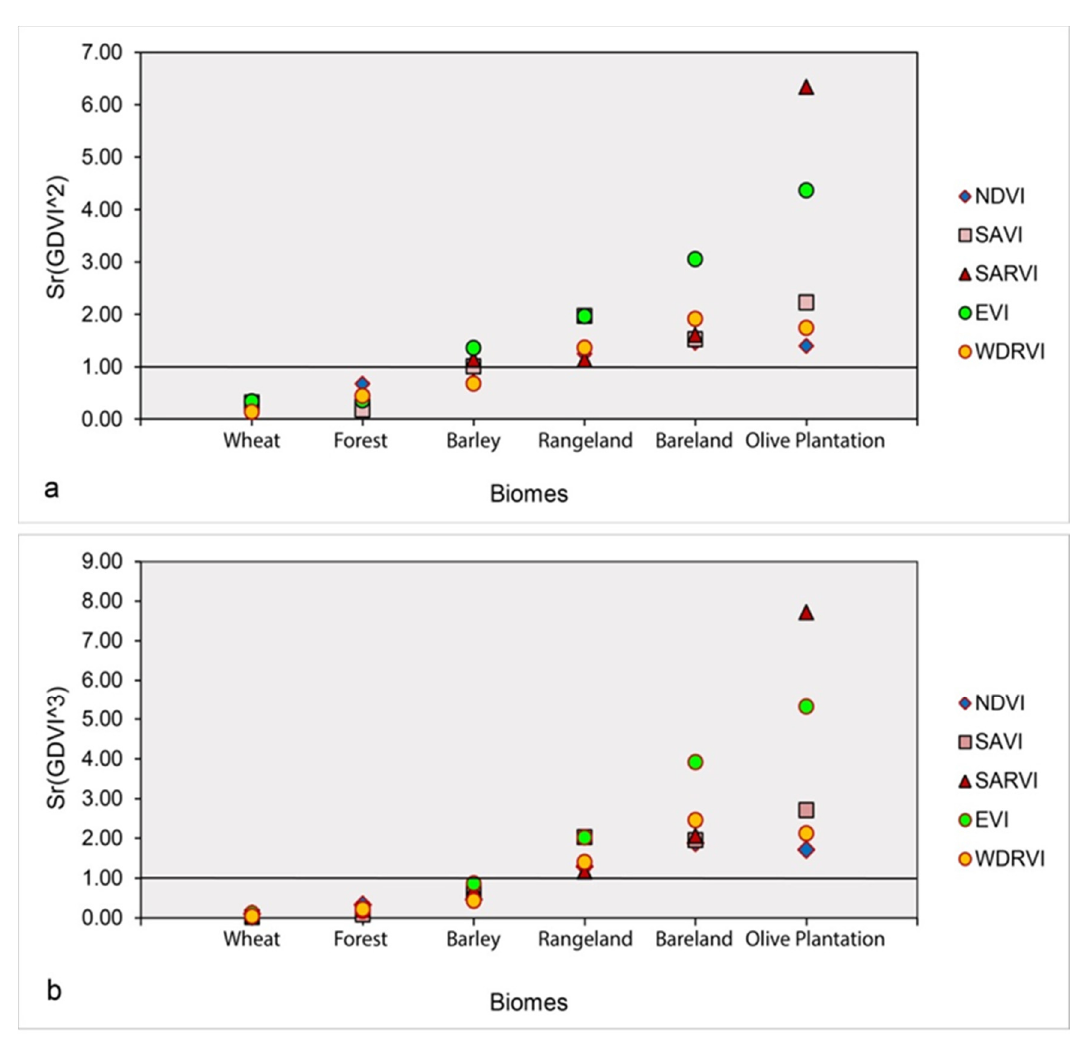
Figure 6. Sensitivity of GDVI vs . other vegetation indices for different biomes (image dated 1 May 2007. ( a ) GDVI^2 vs. VIs, ( b ) GDVI^3 vs. VIs, and ( c ) GDVI^4 vs .